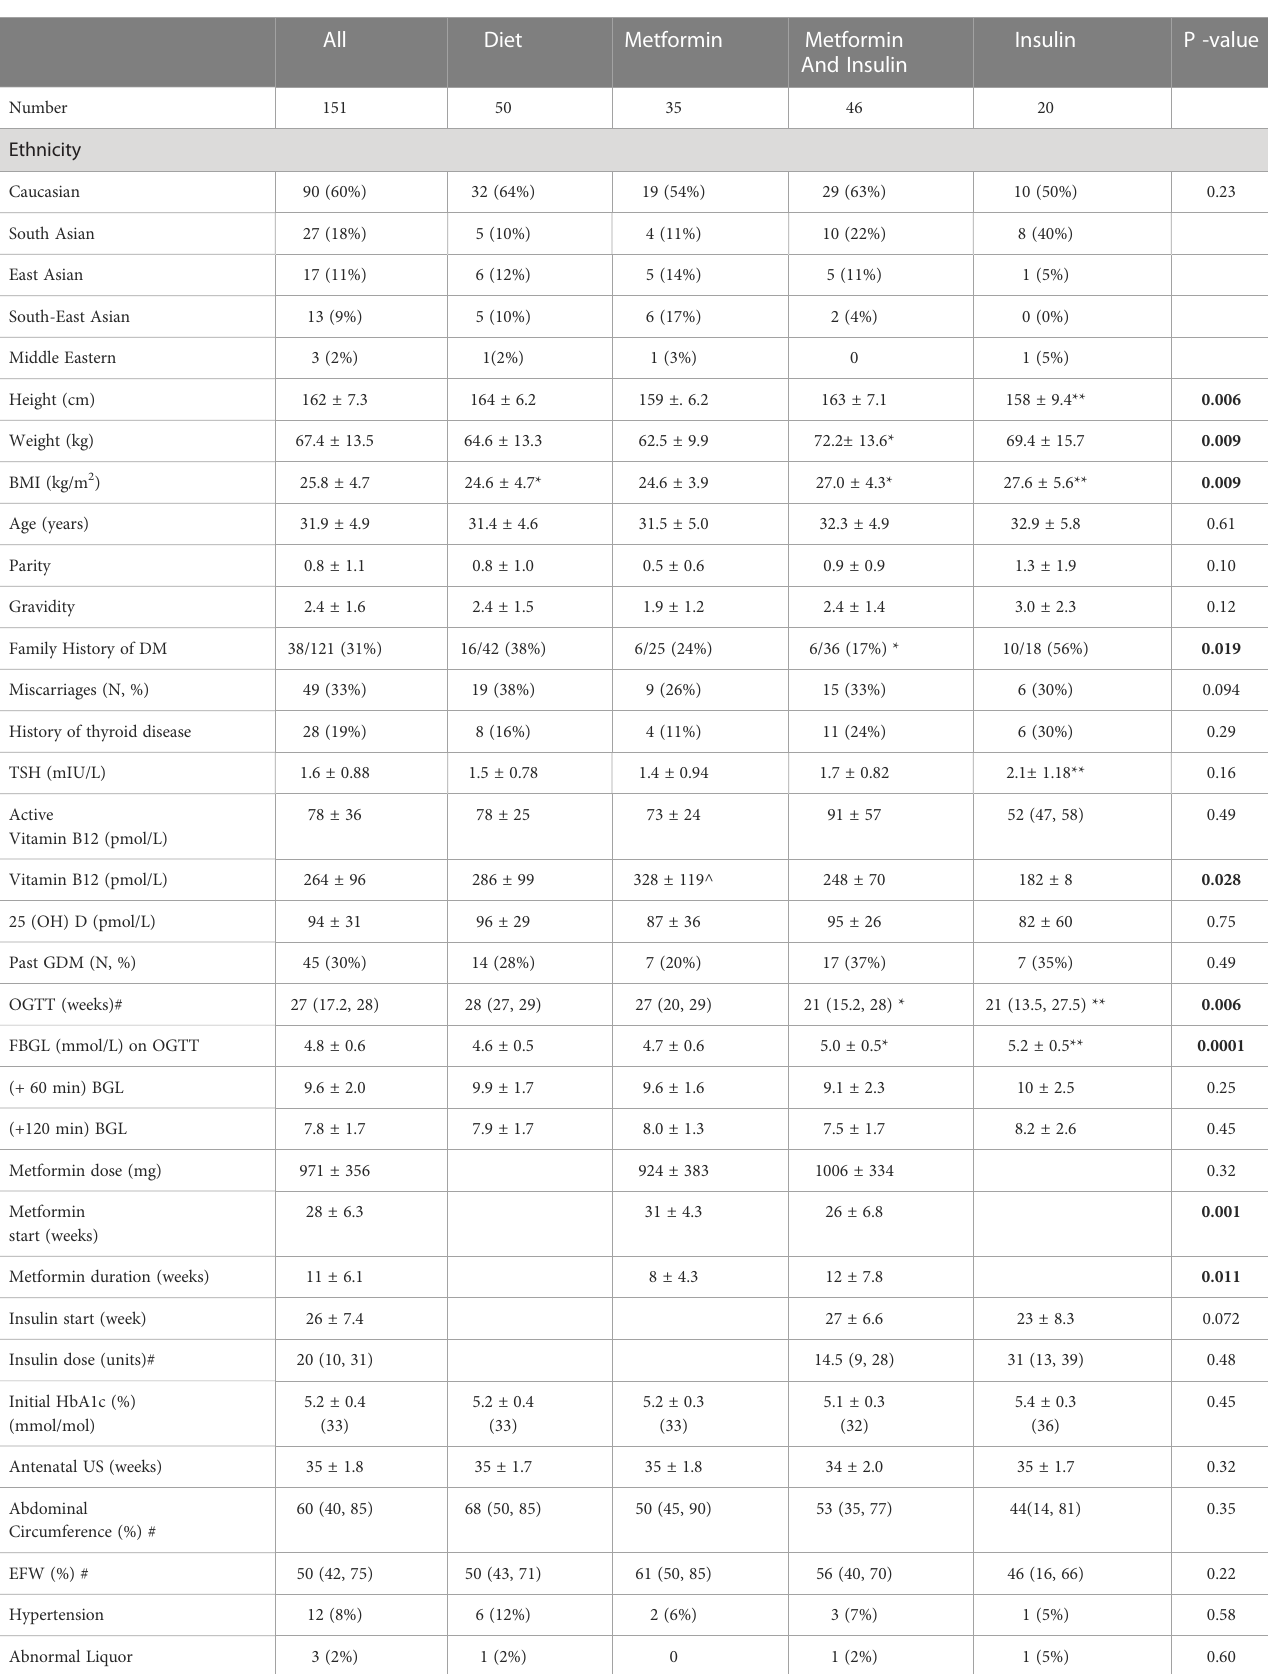
TABLE 1 Baseline characteristics of study